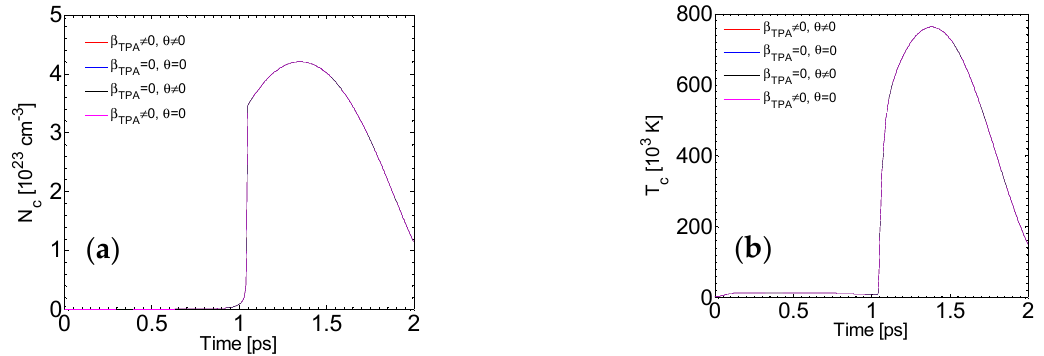
Figure A2. Simulation results of maximum carrier density ( a ) and carrier temperature ( b ) for t delay = 0 ps, E p = 50 mJ/cm 2 for (100) TiO 2 .